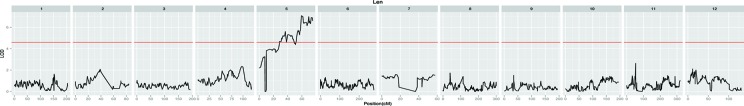
Needling length traits-associated QTLs in jujube among all linkage groups.